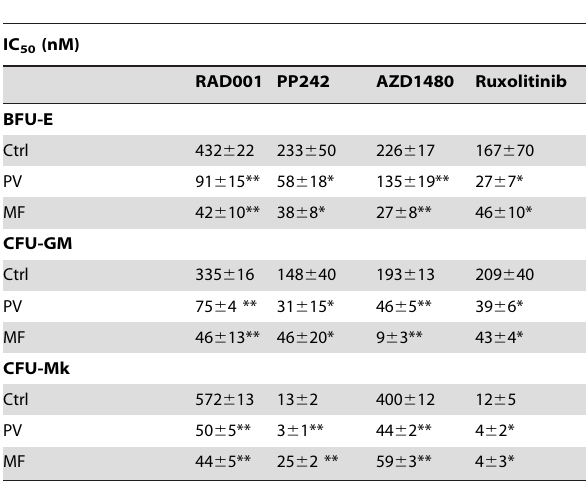
The IC50 was calculated using data derived from the sensitivity curves to drugs reported in Figure 3. *, P , 0.05, **, P , 0.01. Figure 1B. The IC 50 for VF and wt Ba/F3-EPOR cells was 4 6 2 nM versus 22 6 10 nM and 47 6 12 nM versus 308 6 100 nM for RAD001 and PP242, respectively, and 19 6 11 nM versus 750 6 100 nM and 20 6 15 nM versus 740 6 100 nM for AZD480